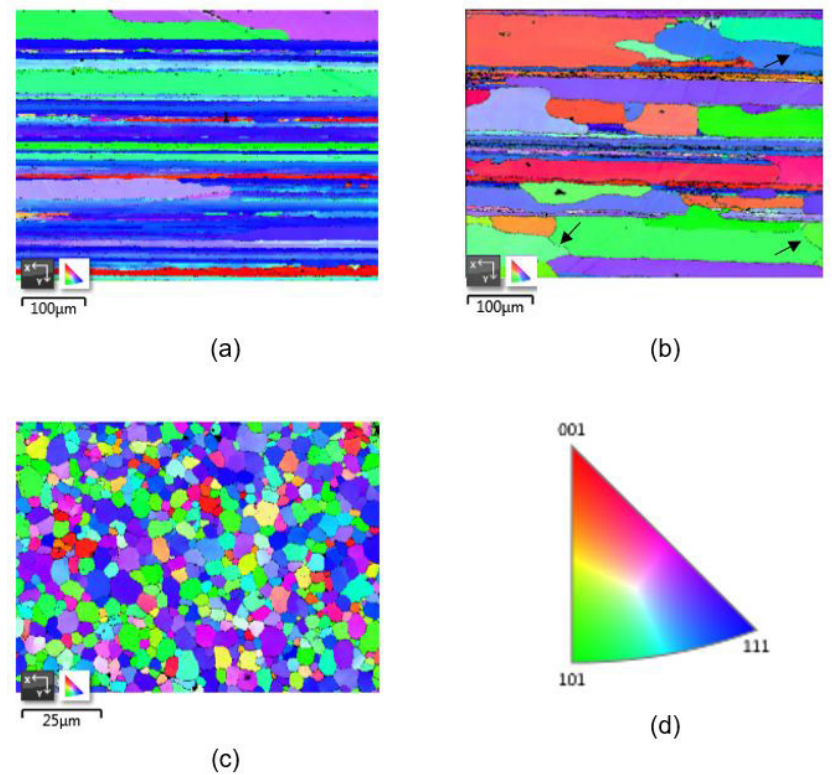
Figure 8. EBSD maps of different welding zones: (a) BM, (b) HAZ, (c) SZ and (d) crystallographic reference. Black arrows in (c) indicated the formation of subgrains in the